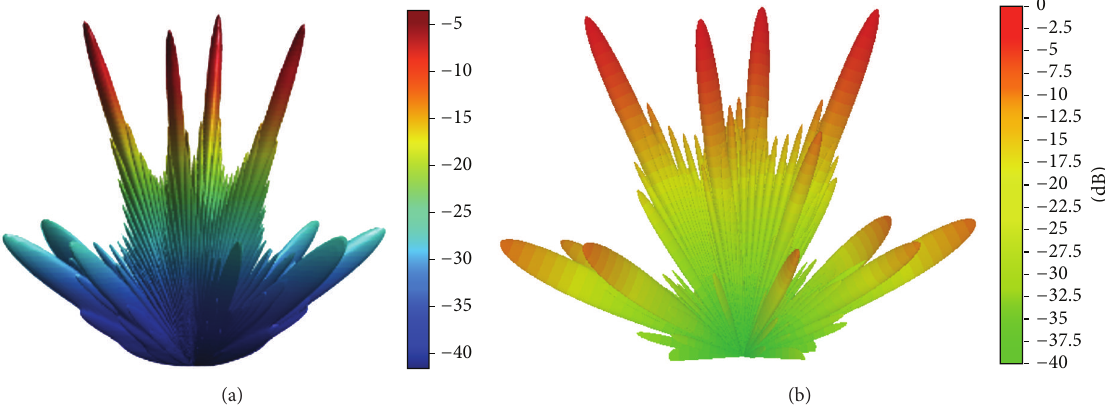
Figure 5: Scattering patterns of the metasurface with periodic arrangement at 17 GHz. (a) The normalized analytical results calculated by (3). (b) The full-wave simulation results.